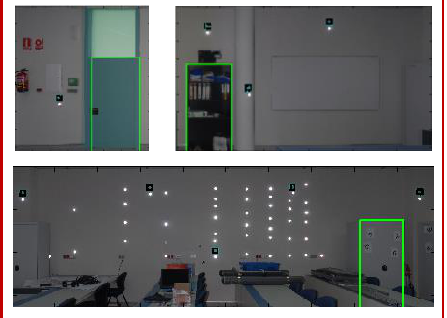
Figure 6. A closed-door (upper-left), a bookshelf (upper-right) and a cupboard (down) are detected as door candidates.